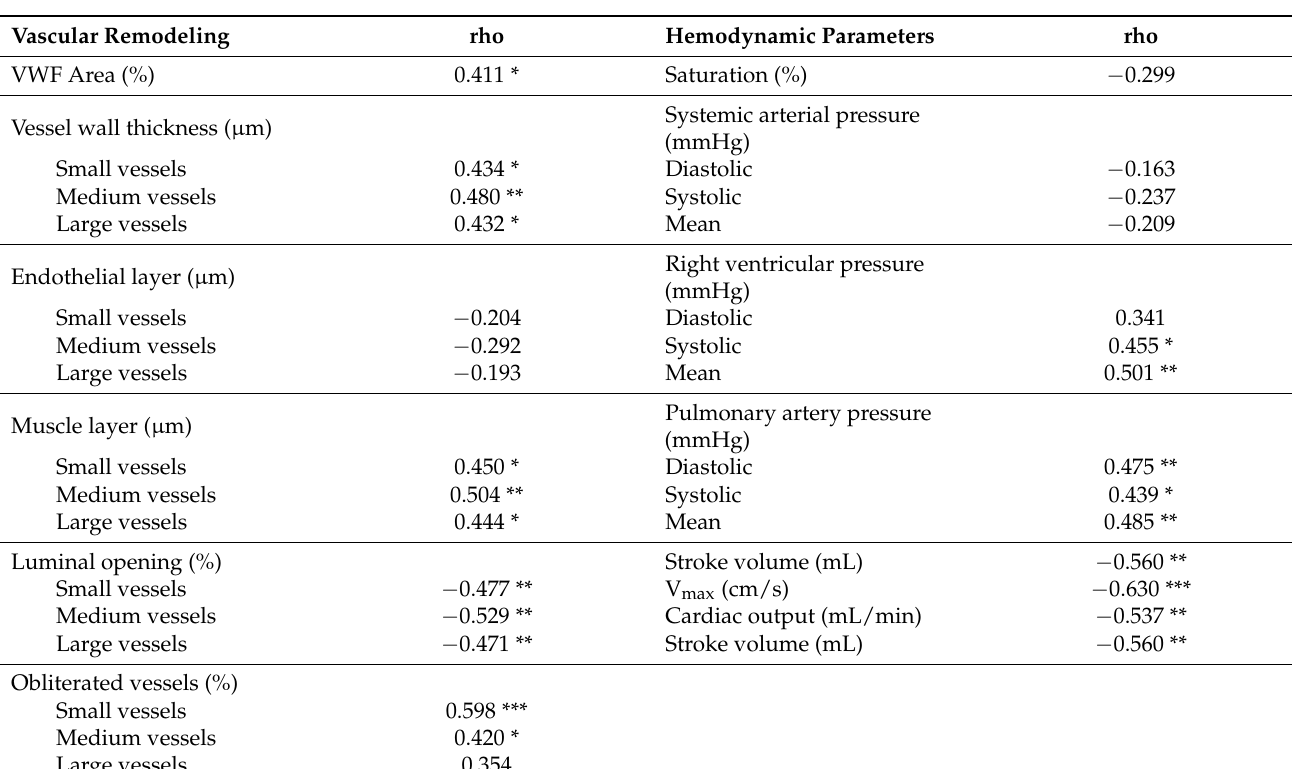
Table A5. Correlation between right ventricular hypertrophy (Fulton’s index) and histopathological signs on vascular remodeling and hemodynamic parameters in animals exposed to SuHx and treated with vehicle or